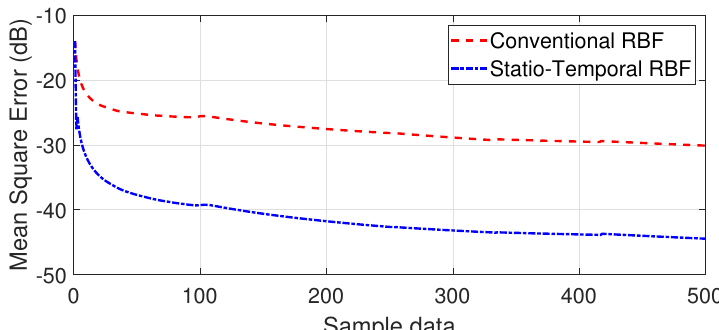
Figure 5. Testing MSE curves of ST − RBF and conventional